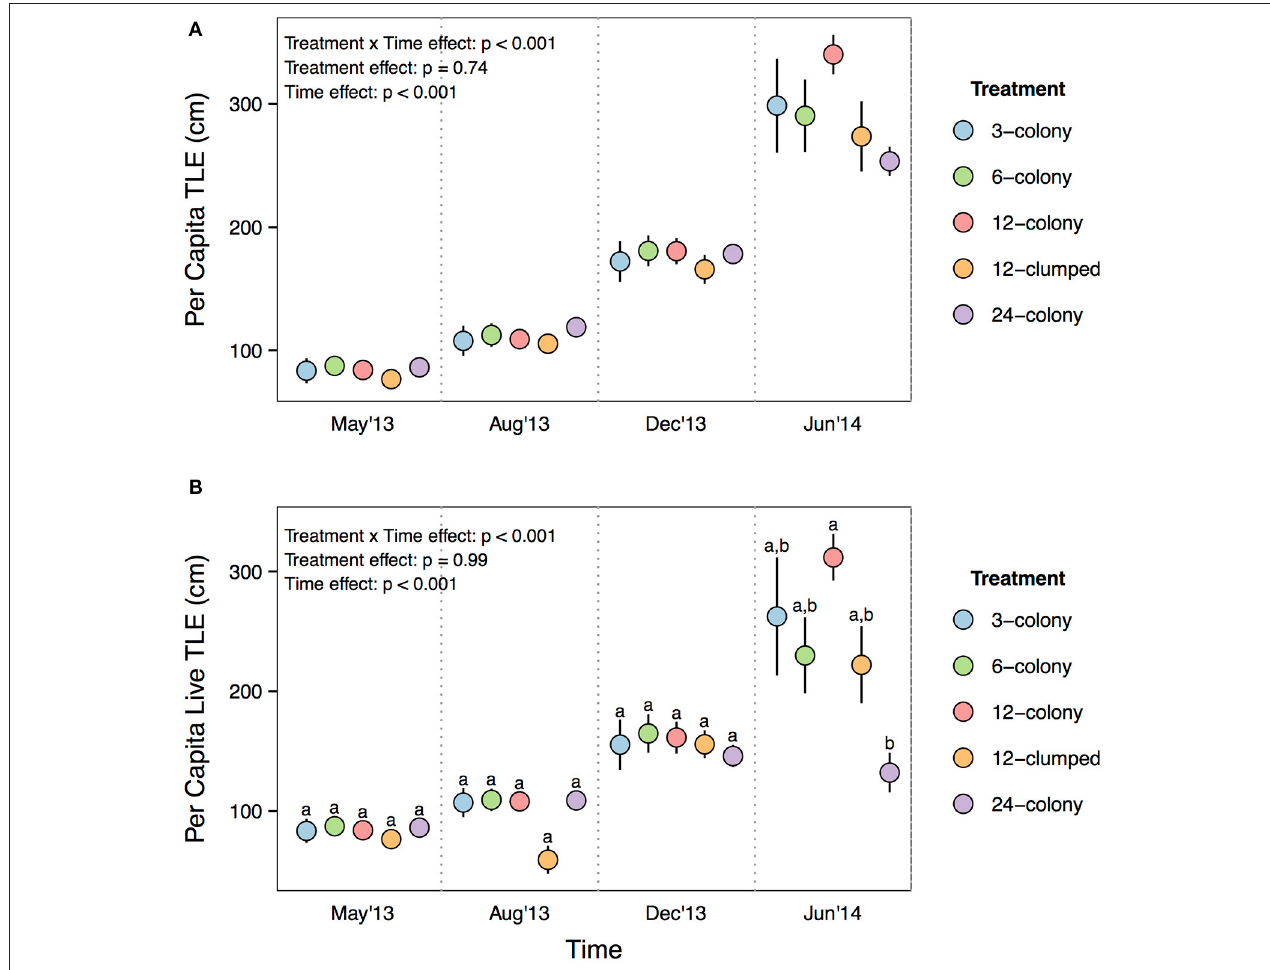
FIGURE 3 | (A) Per capita total linear extension (TLE) and (B) per capita live TLE of individual corals by treatment through time. Labels on x-axis indicate the time at which each survey was conducted. Statistics are from nested two-way repeated measures ANOVA. Letters represent significant differences ( p < 0.05) among treatments within a time period from post-hoc tests with Tukey’s correction. Data are means ±